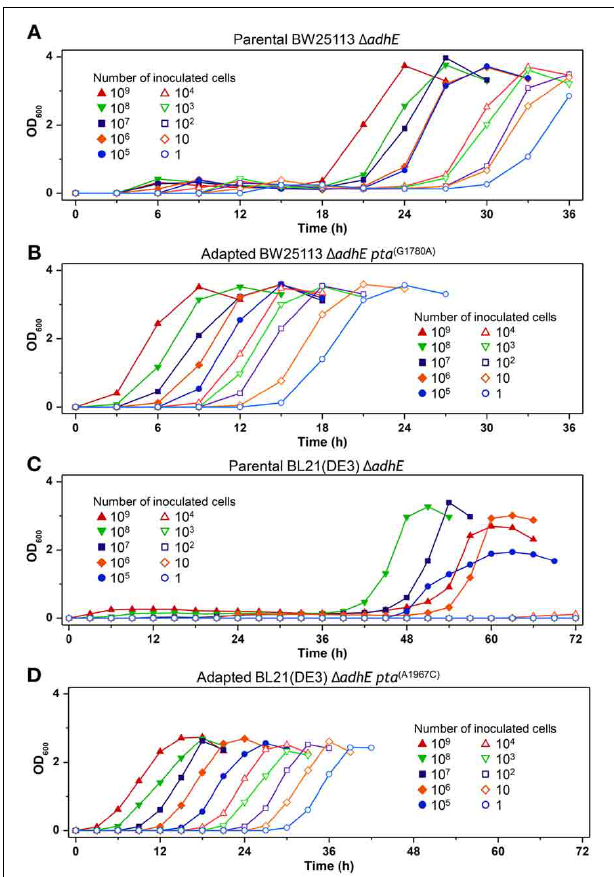
FIGURE 11 | Inoculum dilution effects on anaerobic growth profiles of parental and adapted cells of BW25113 (cid:2) adhE (A), BL21(DE3) (cid:2) adhE (B), adapted BW25113 (cid:2) adhE pta (G1780A) (C), and adapted BL21(DE3) (cid:2) adhE pta (A1967C)